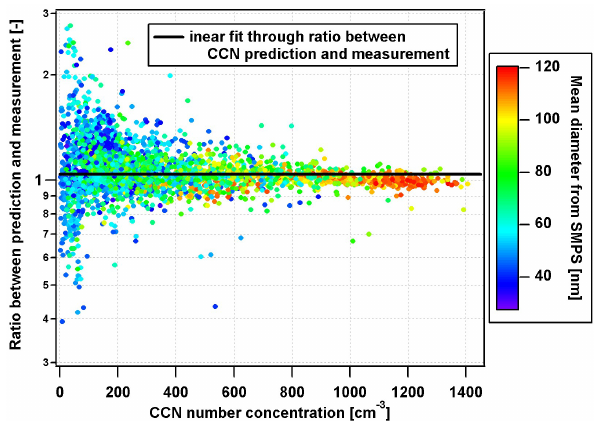
Fig. 5. The predicted-to-measured CCN number concentration at all SS as function of the CCN number concentration coloured after the mean diameter of the number size